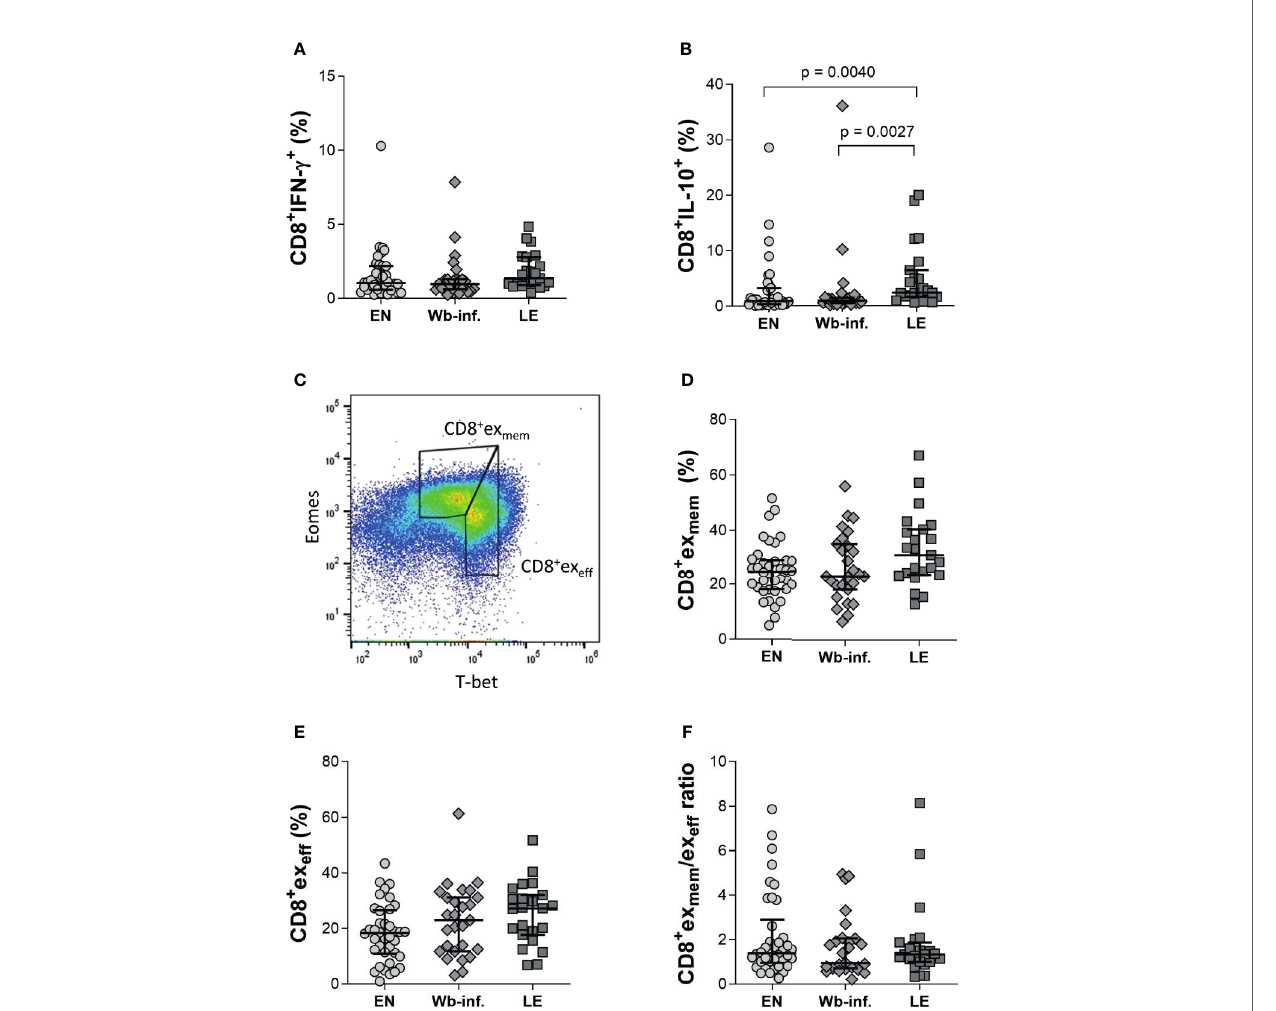
FIGURE 2 | Comparable ratios of CD8 + ex mem and CD8 + ex eff T-cell subsets within EN, Wb-infected, and LE groups. Cell populations were analyzed according to the applied gating strategy ( Supplementary Figures S2 , S3 ). Levels of intracellular IFN- g (A) and IL-10 (B) from CD8 + T cells were measured using isolated PBMC fractions in endemic normal (EN, n = 38), Wuchereria bancrofti infected (Wb-inf., n = 27), and lymphedema (LE, n = 23) subjects. Representative gating strategy to distinguish the CD8 + ex mem (CD8 + T-bet dim Eomes hi ) and CD8 + ex eff (CD8 + T-bet hi Eomes dim ) expression on CD8 + T cells in PBMC samples (C) . The frequencies of CD8 + ex mem (D) and CD8 + ex eff (E) cell subsets in PBMCs were also compared as well as the ratios of CD8 + ex mem /CD8 + ex eff (F) . Symbols in graphs show individual data points with median and IQR. Statistical signi fi cances between the groups were obtained using Kruskal-Wallis followed by Dunn ’ s multiple comparison post hoc